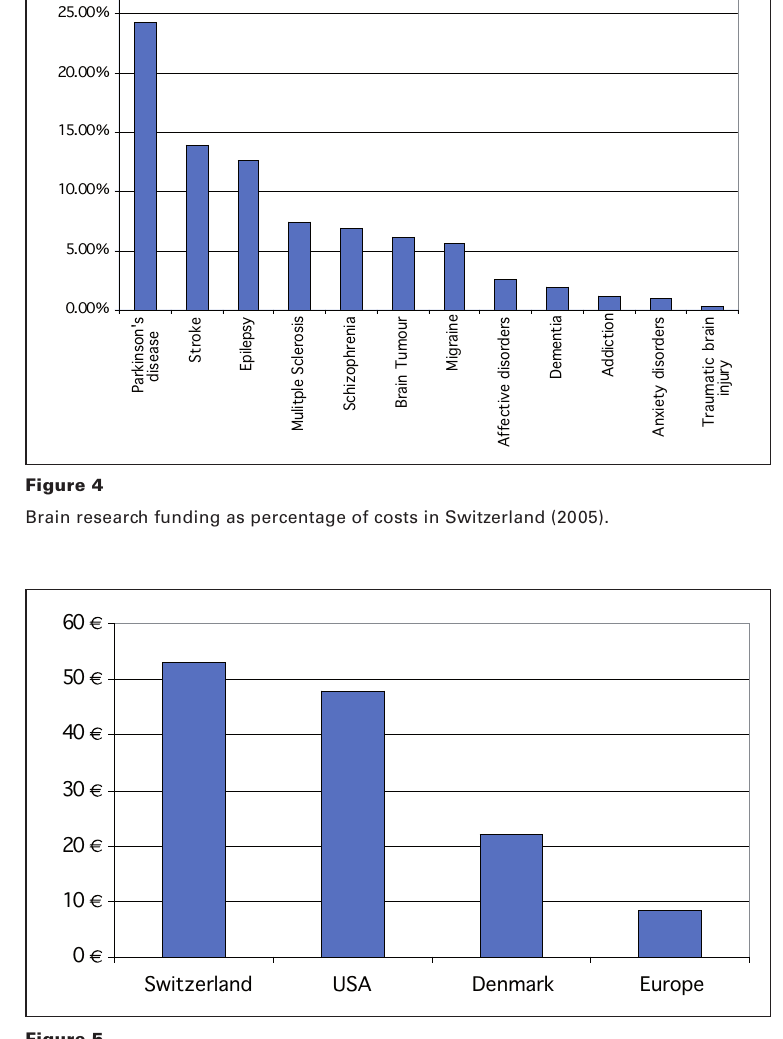
Brain research funding per capita for Switzerland, Europe, Denmark and US (2005).